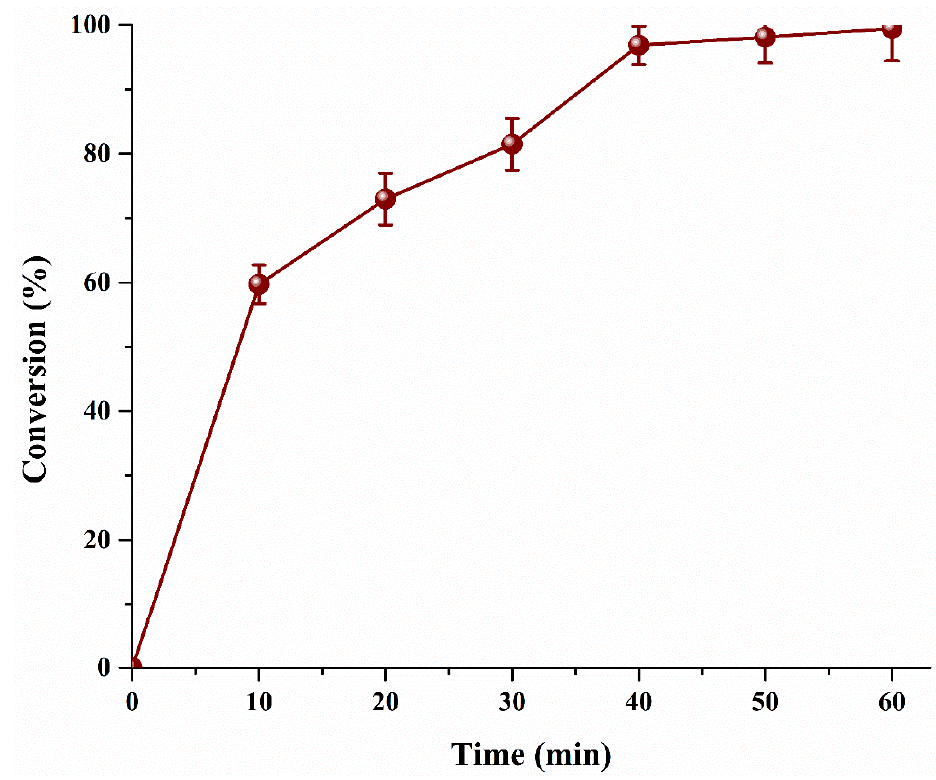
Figure 7. Effect microalgae oil conversion with respect to reaction time. Table 3. The comparison of current up-scaling study with other conventional catalyst based biodiesel production .